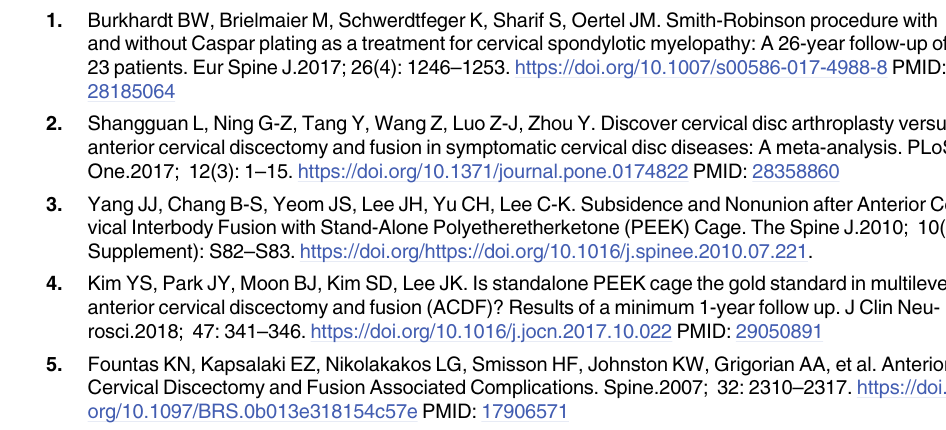
S1 Table. Comparative analysis data of two fixation systems during different neck motion